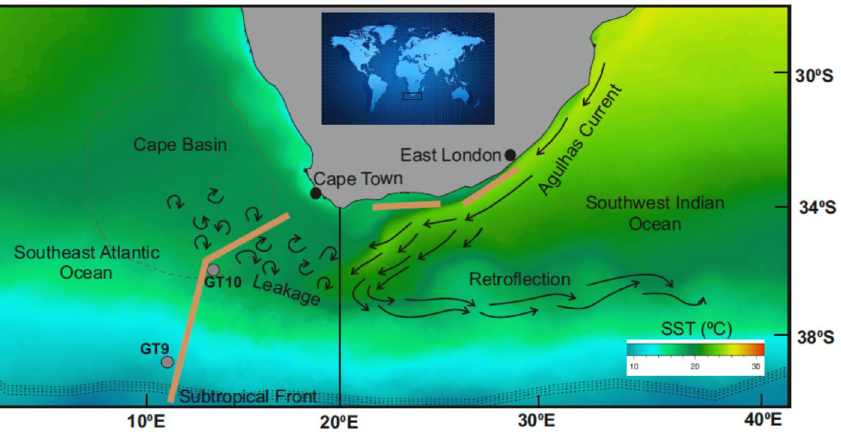
Figure 1. Sea Surface Temperature (SST) map of the study area showing the idealised pathway of Agulhas water and associated eddies that transfer seawater from the Indian Ocean to the South Atlantic Ocean. A zoomed- out map of the study area is shown within the black square in the globe. Surface water was sampled along the transects shown by light brown lines, and the grey circles (GT9 and GT10) indicate the location of CTD stations where vertical profiles were obtained. The black vertical line is the approximate boundary between the Indian Ocean and the Atlantic Ocean. Source of the SST data: https:// ocean color. gsfc. nasa.